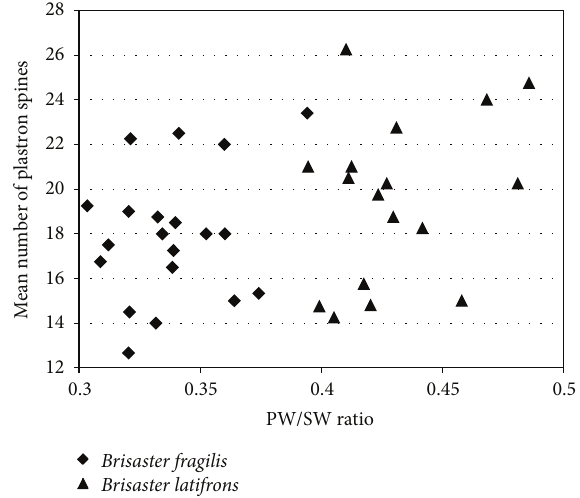
Figure 2: Comparison of the mean number of plastron spines (across midsection of plastron) against the ratio of plastron width (PW, at midsection) over the maximum specimen width